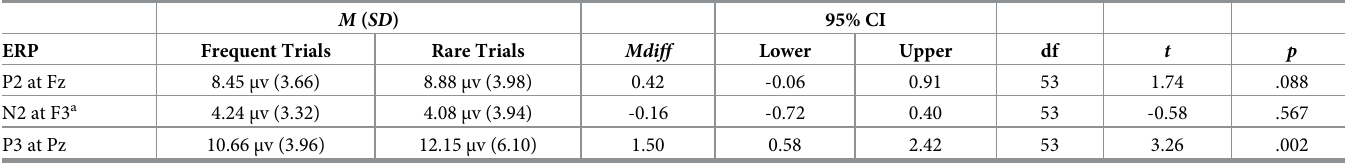
Grand averaged ERP amplitudes (in microvolts) on the oddball task for frequent and rare trials. ERPs were time-locked to the presentation of the visual stimulus. a N2 is a negative going potential, thus smaller values indicate larger ERP amplitude. Dependent Variable = ERP mean amplitude. CI = confidence interval.